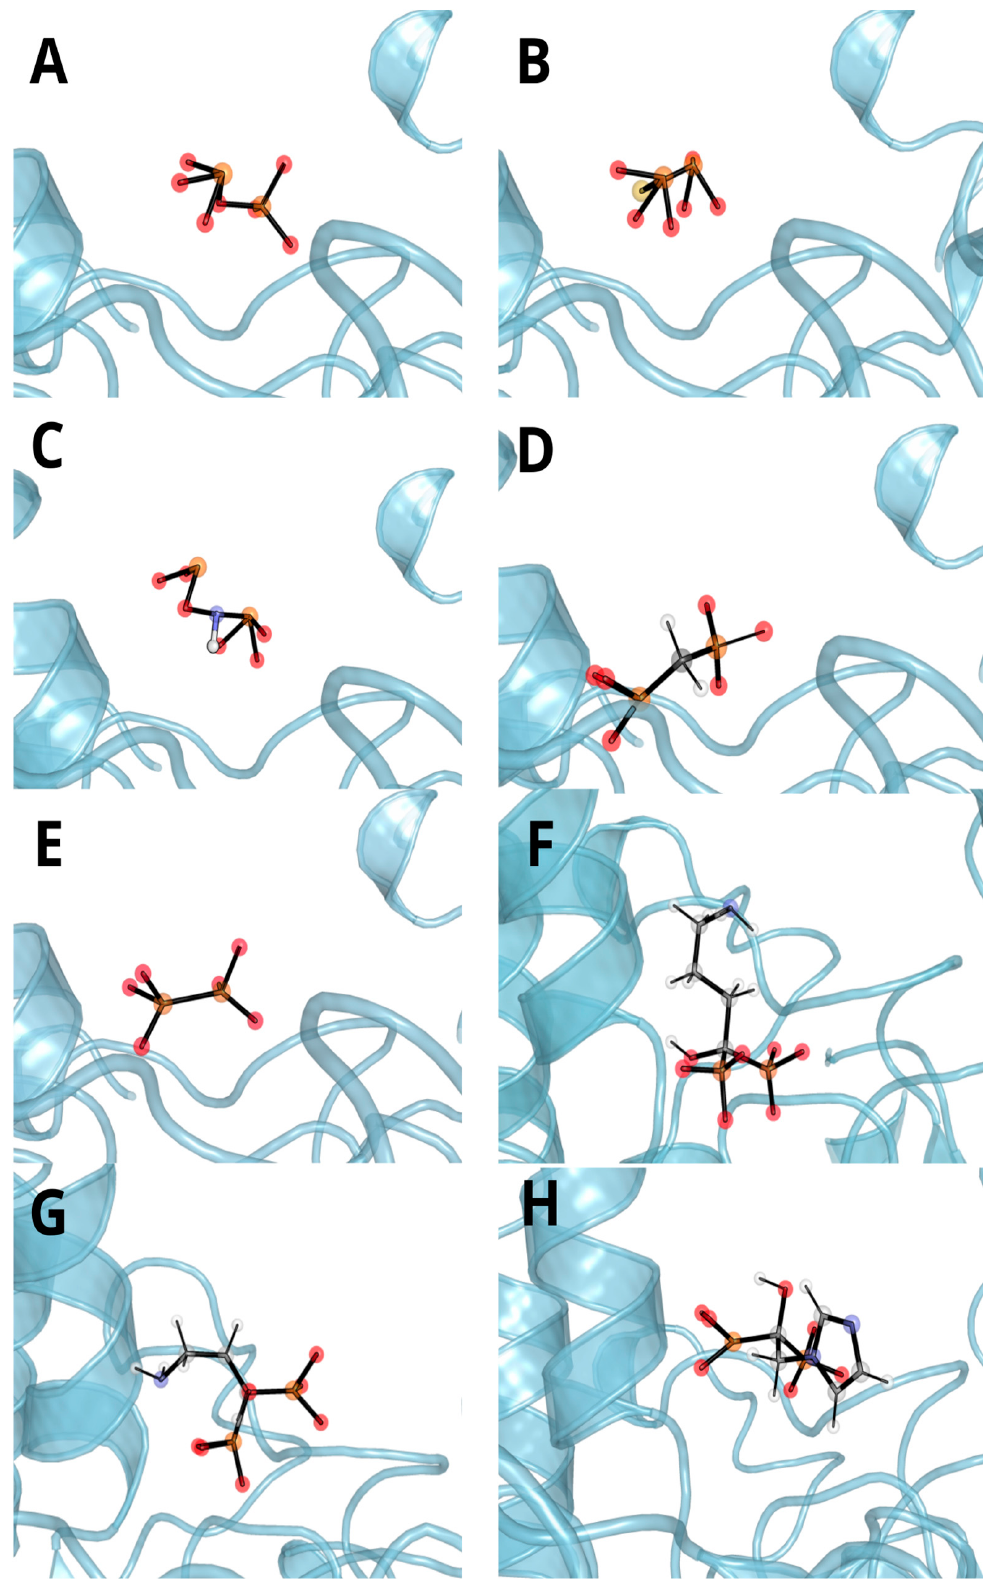
Figure 7. Ligand in the TNAP cavity for ( A ) pyrophosphate, ( B ) monothiopyrophosphate, ( C ) imidodiphosphate, ( D ) methylenediphosphonic acid, ( E ) hypophosphate, ( F ) alendronate, ( G ) pamidronate and ( H ) zoledronate from clustered trajectories.